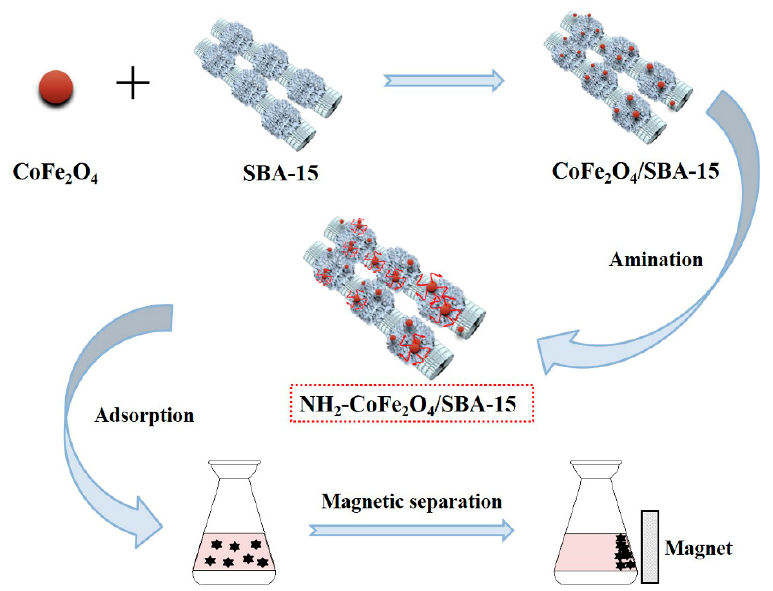
Figure 1. The schematic diagram for the application of NH 2 − CoFe 2 O 4 /SBA − 15 toward Pb 2+ adsorp- tion in the presence of external magnetic field.